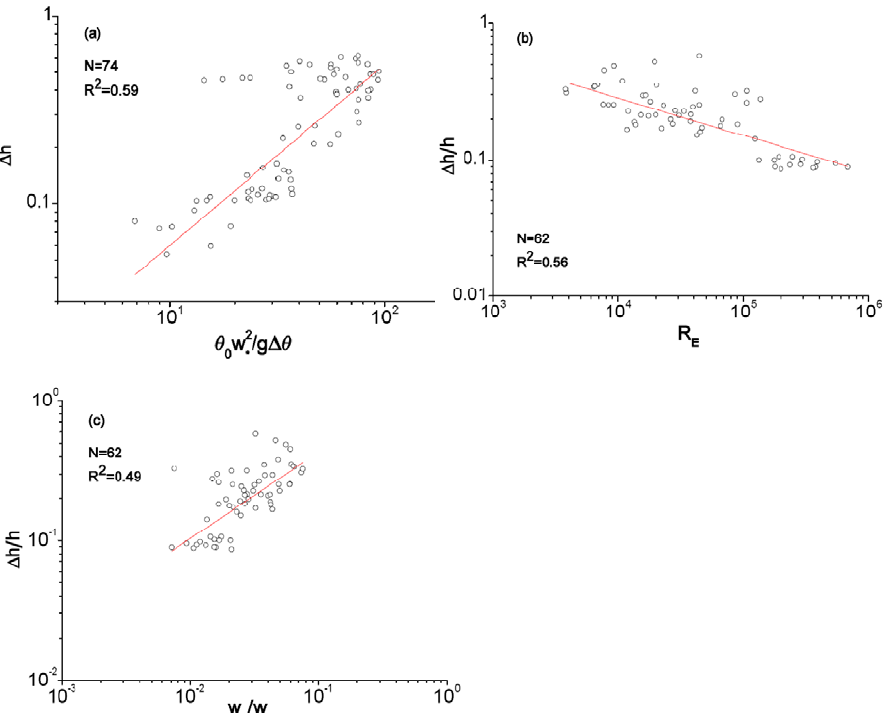
Fig. 6. Comparison of entrainment zone data with theoretical values: (a) entrainment zone thickness, (b) normalised entrainment zone thickness and entrainment Richardson number, (c) normalised entrainment zone thickness and ratio of entrainment velocity and convective velocity Fig. 6: Comparison of entrainment zone data with theoretical values: a) entrainment 504 zone thickness, b) normalized entrainment zone thickness and entrainment Richardson 505 number, c) normalized entrainment zone thickness and ratio of entrainment velocity 506 and convective velocity scale. 507 508